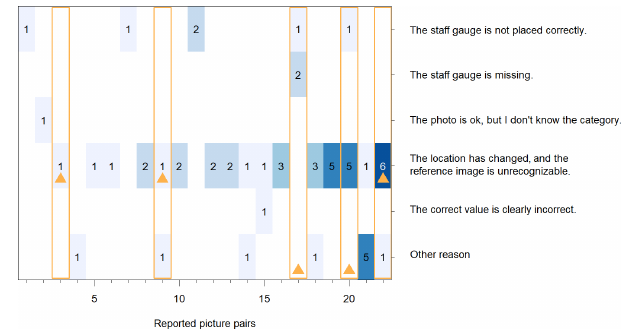
Figure 5. The number of times that a picture pair was reported and the reason for reporting the picture pair ( y axis) for the 22 pic- ture pairs in the game that were reported at least once ( x axis). The picture pairs that should have been reported based on expert assess- ment prior to the training study are framed with an orange rectangle; the orange triangle indicates the reason based on expert assessment. The blue shading represents the number of reports per picture pair (as also indicated by the printed